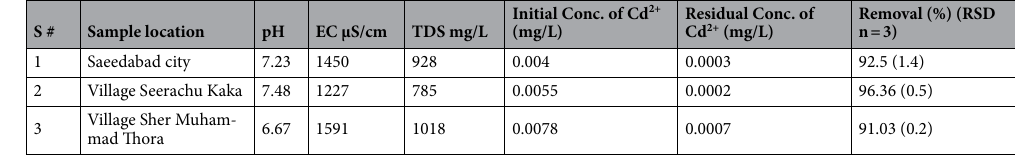
Table 10. Cadmium ions removal from groundwater